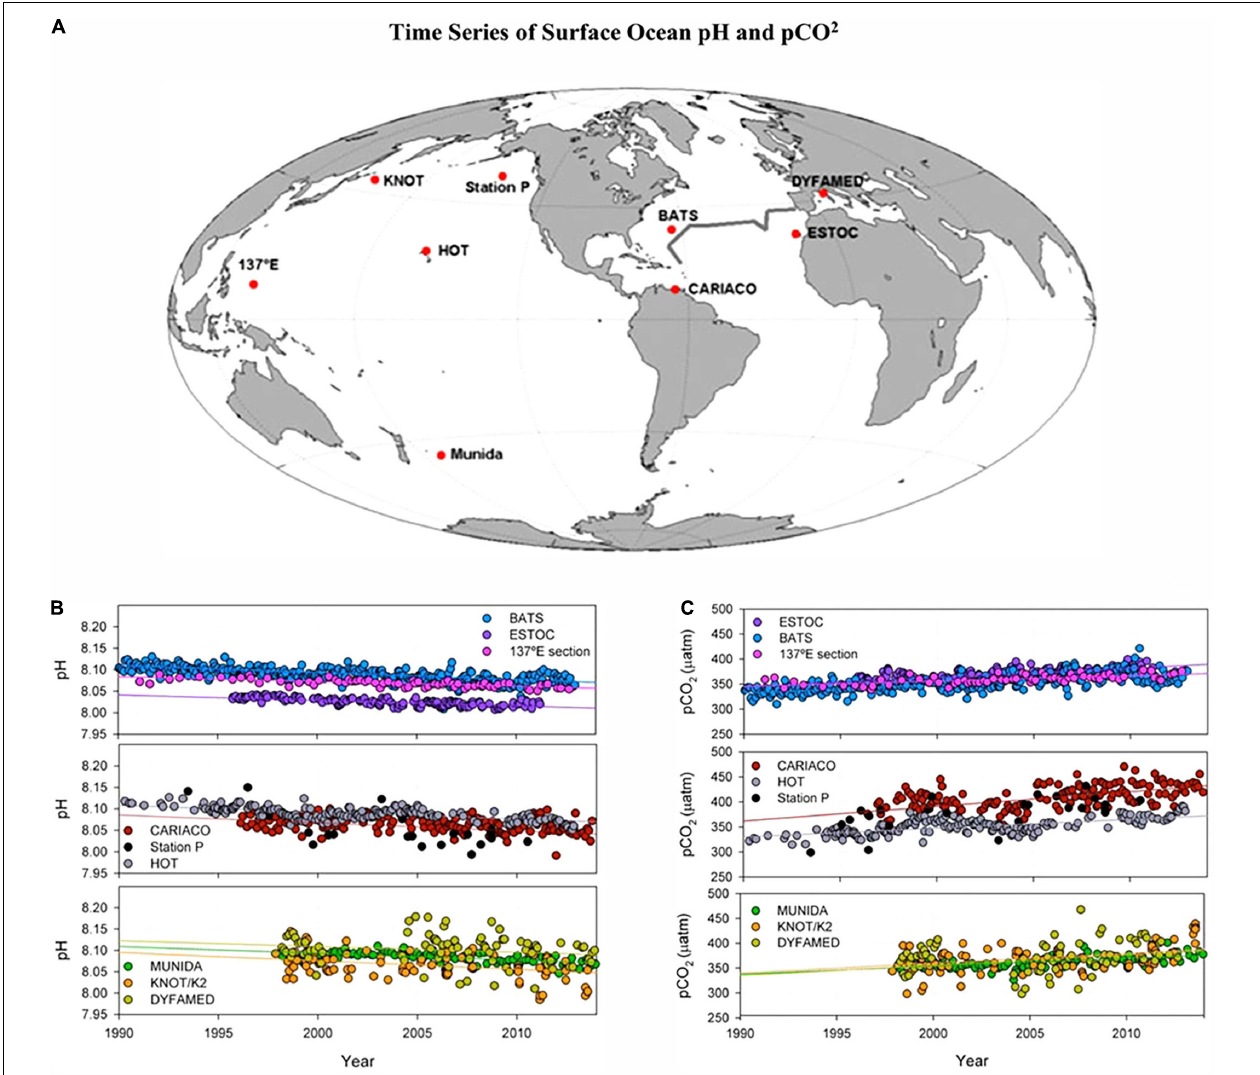
FIGURE 3 | Trends in surface ( < 50 m) ocean carbonate chemistry calculated from observations obtained at global monitoring stations. (A) Positions of time-series stations (red dots). (B) Time series of deseasonalized surface ocean pH measurements and trend lines. pH is on total scale for in-situ temperatures. (C) Time series of deseasonalized surface ocean pCO2 measurements and trend lines. Figure from Tanhua et al. (2015).